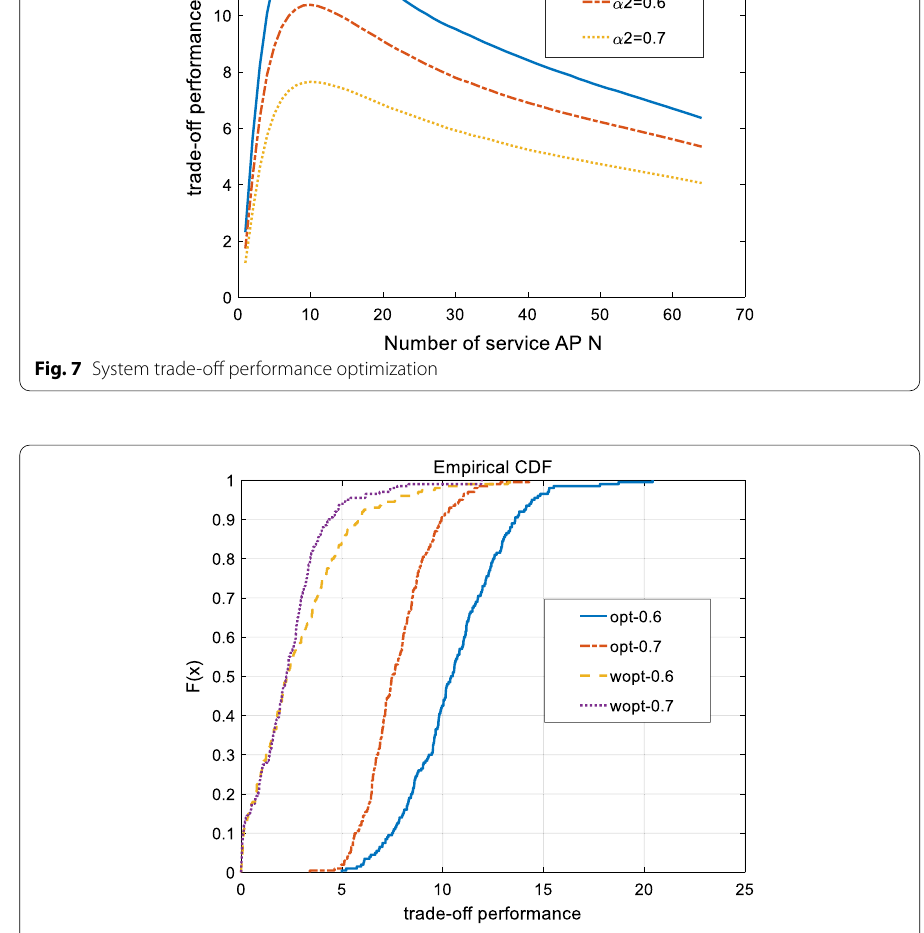
Fig. 8 Comparison of trade-off performance optimized unoptimized, α 2 = 0.6 , α 2 =